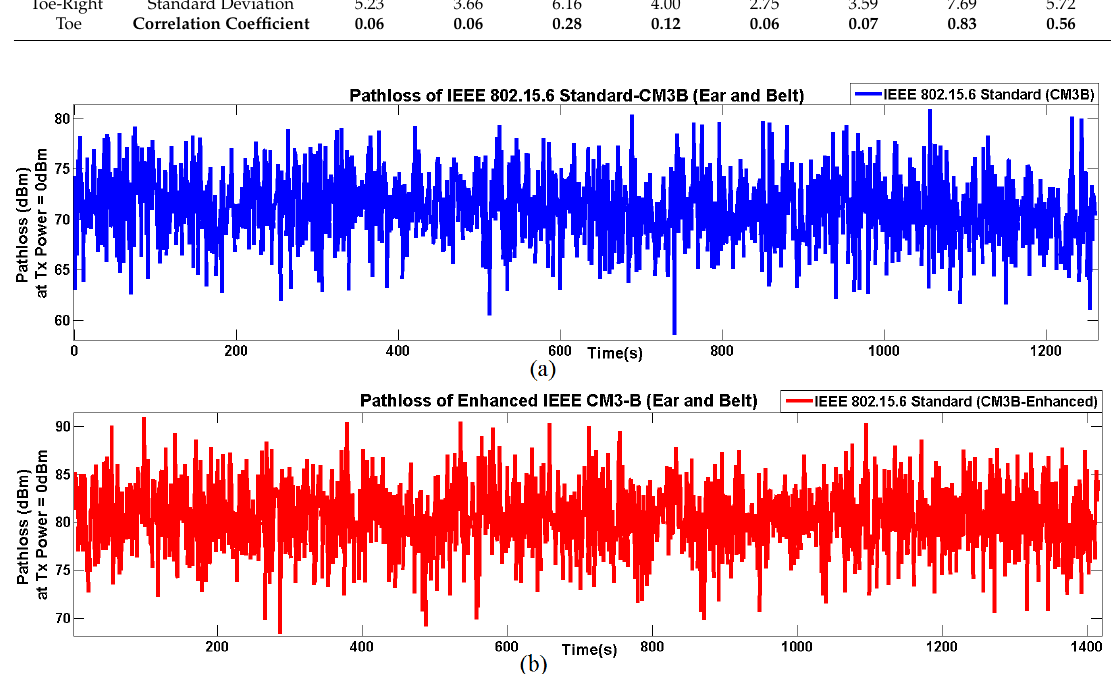
Figure 12. Path loss comparison of CM3-B versus enhanced CM3-B at 2450 MHz. ( a ) Pathloss of IEEE 802.15.6 standard CM3-B between (Ear and belt); ( b ) Pathloss of Enhanced IEEE 802.15.6 standard E-CM3-B between (Ear and